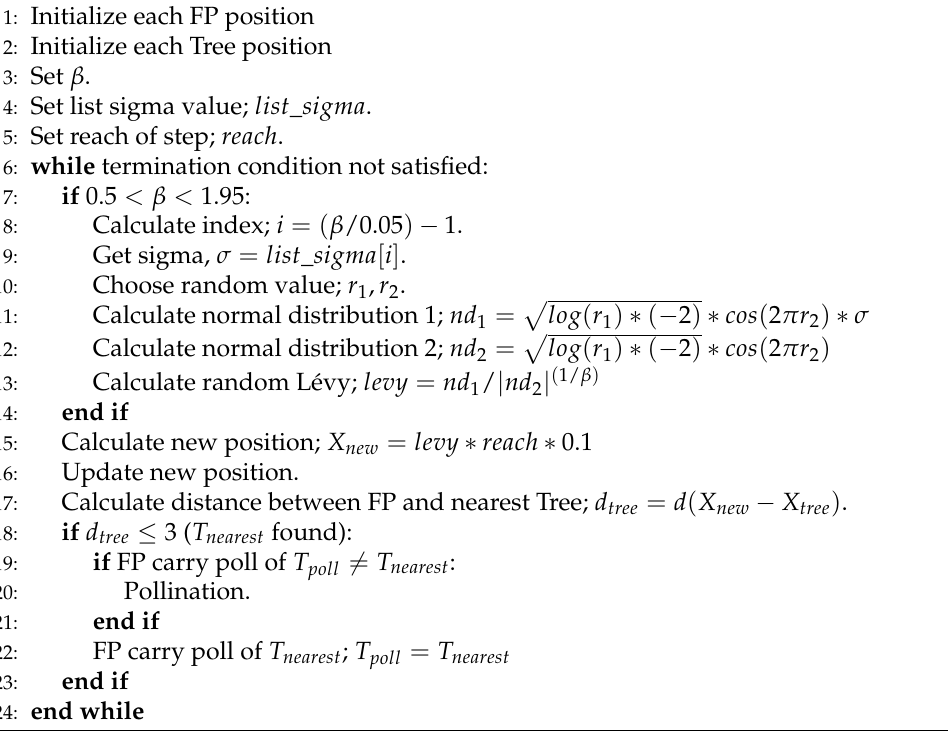
Algorithm 4 Individual Lévy